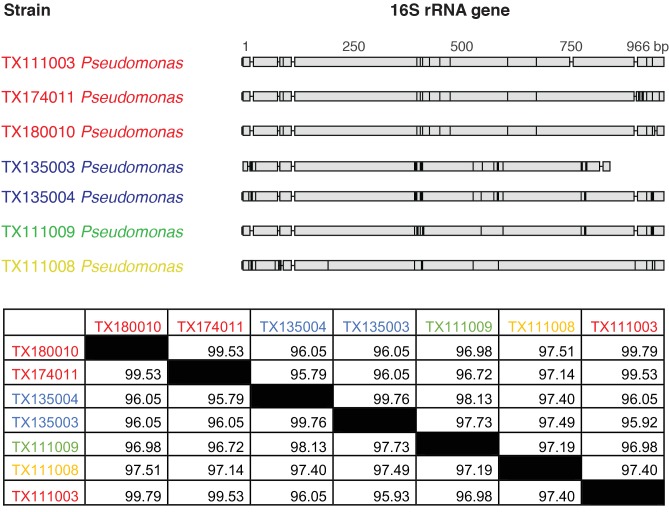
Pairwise comparison of 16S rRNA sequences between TTX-producing strains of Pseudomonas spp. identified in this study.Gray regions represent invariable sites, while black bars show mutations. Strains TX111003, TX174011, and TX180010 and strains TX135003 and TX135004 each share >99% pairwise nucleotide identities, but the two groups appear to be distinct from each other. Sequences TX111009 and TX111008 share around 96–97% nucleotide identities with the other two groups, but each possesses unique mutations indicating that they are distinct strains of Pseudomonas. Nucleotide identities are shown as percentages (%) for each pairwise sequence comparison. Sequence groups with >99% nucleotide identities are indicated through color coding and were considered replicate isolates of the same bacterial strains.